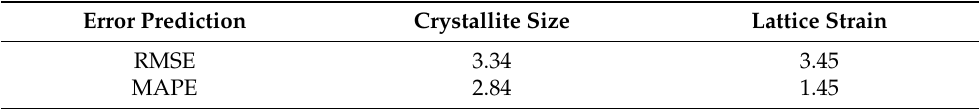
Figure 17. Comparison of the lattice strain (%) with experimental and ANN-predicted values as a function of milling time.